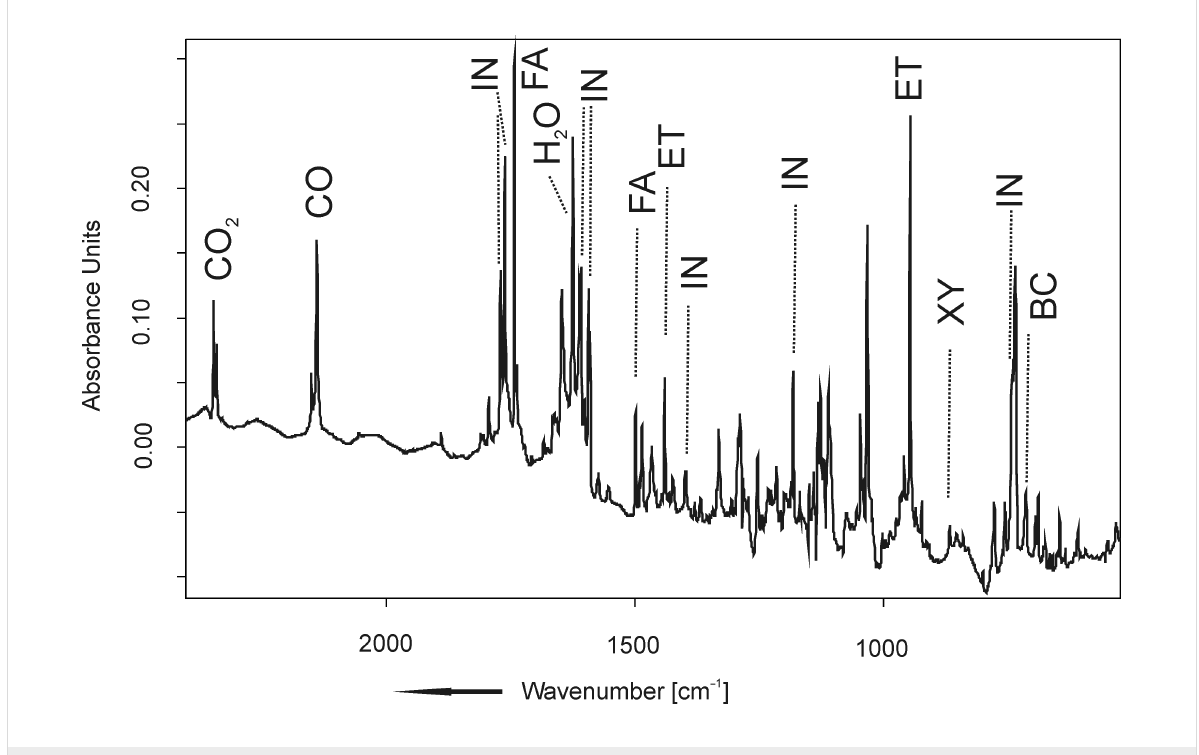
Figure 5: Infrared spectrum obtained upon FVP of 2 at T = 963 K and trapping the pyrolysate in solid argon at T = 10 K.